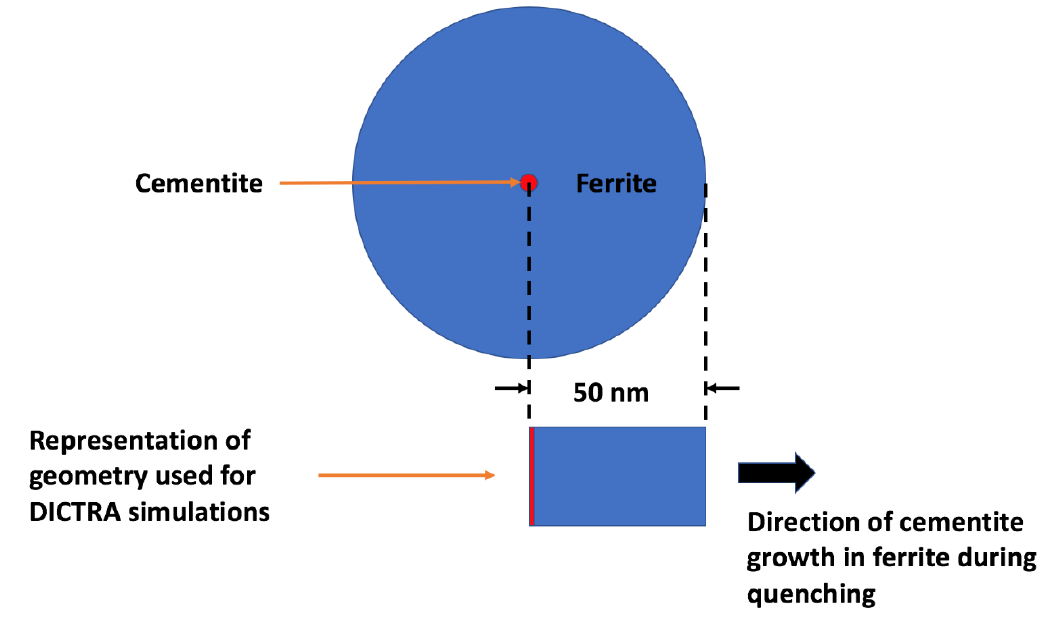
Figure 4. Schematic of the 2D simulation setup used in DICTRA wherein cementite with a radius of 0.1 nm was assumed to be located at the center of a ferrite cylinder of radius of 50 nm.